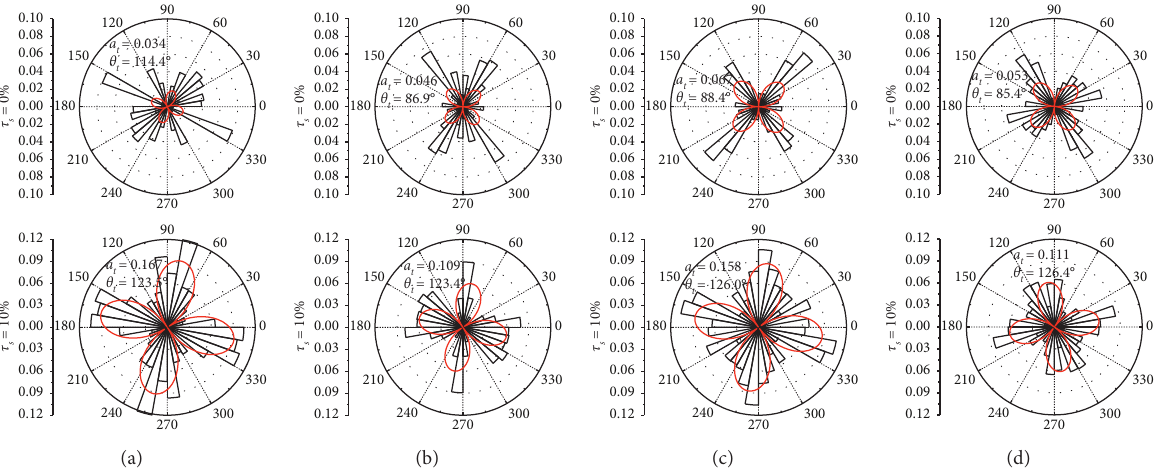
Figure 9: Rosediagramsofcontacttangentialforcedistributionat ε